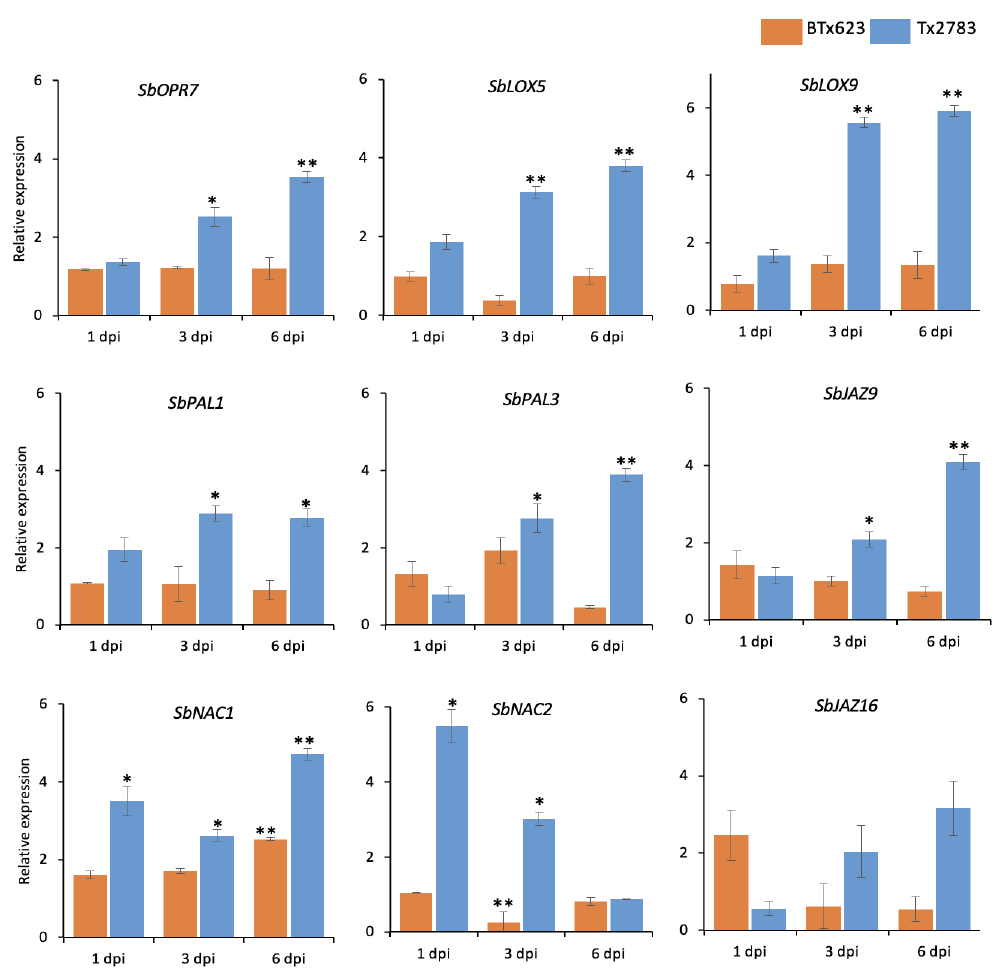
Figure 5. Expression pattern of phytohormone-related genes in response to sugarcane aphid in resistant (Tx2783) and susceptible (BTx623) sorghum genotypes at 1-, 3-, and 6-days post infestation (dpi). qRT-PCR was used to determine the relative expression of each gene using the sorghum α -tubulin gene as a control. Error bars in each bar represent the ± standard error ( n = 3) and asterisks indicate significant differences between the control and aphid treated samples, * p < 0.05, ** p < 0.01. The bars without asterisks are non-significant ( p > 0.05).